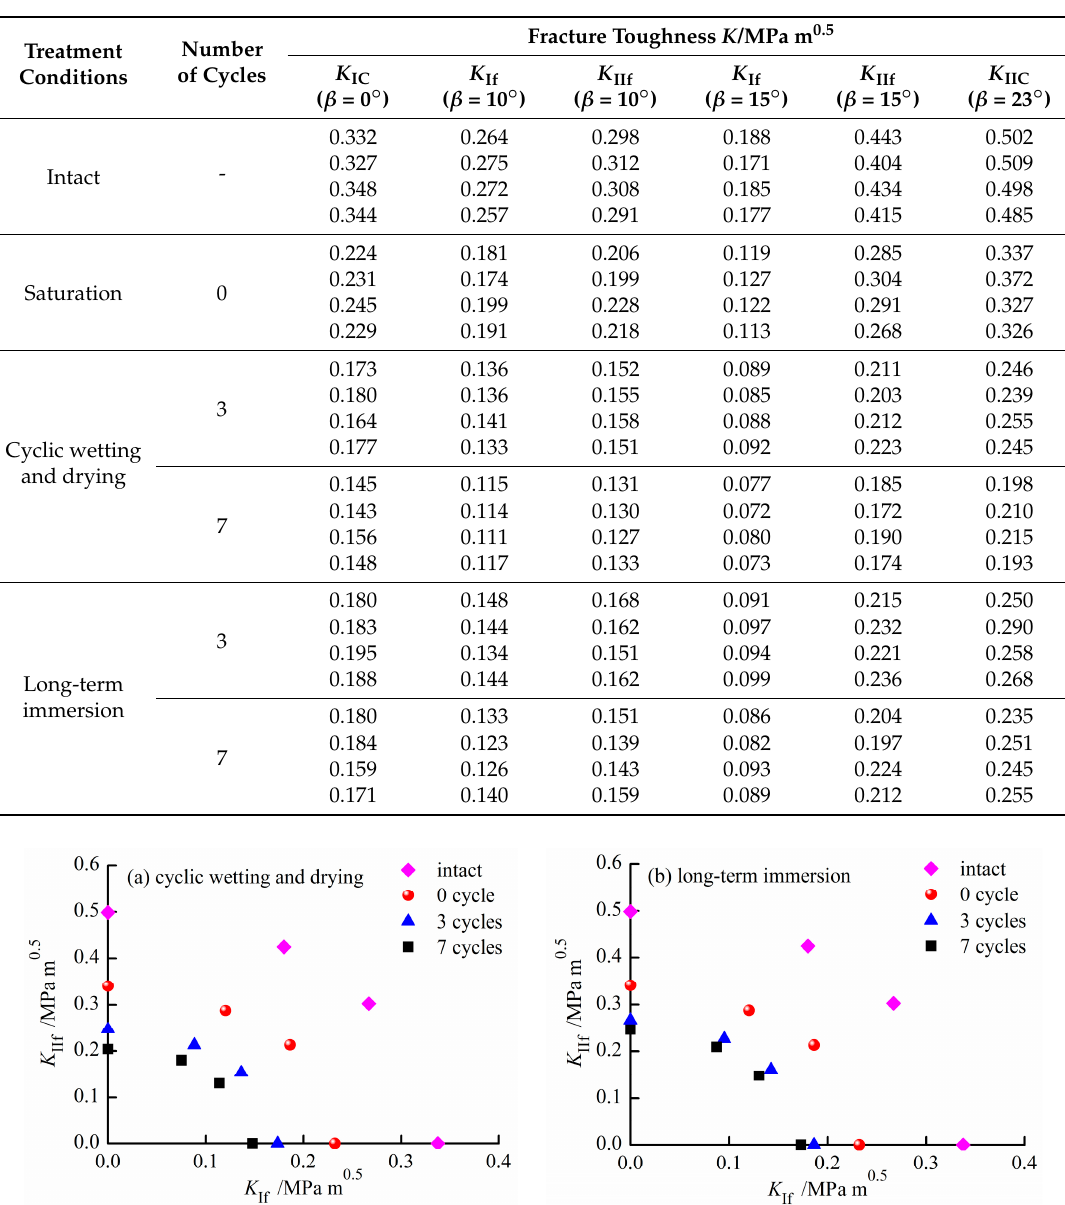
Figure 4. Fracture toughness of sandstone under different water–rock interaction conditions. Table 1. Test values of fracture toughness for sandstone under different water–rock interaction